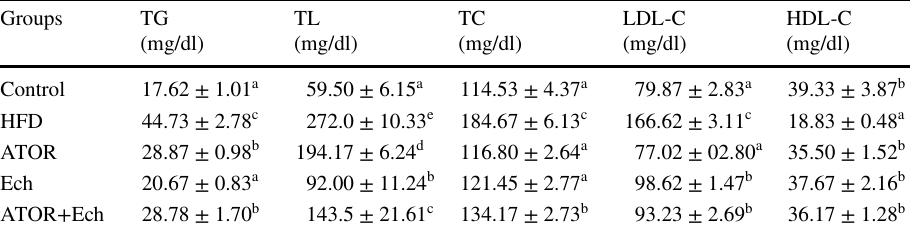
Table 1 Effect of Ech and ATOR on lipid profile in hyperlipidemic rats